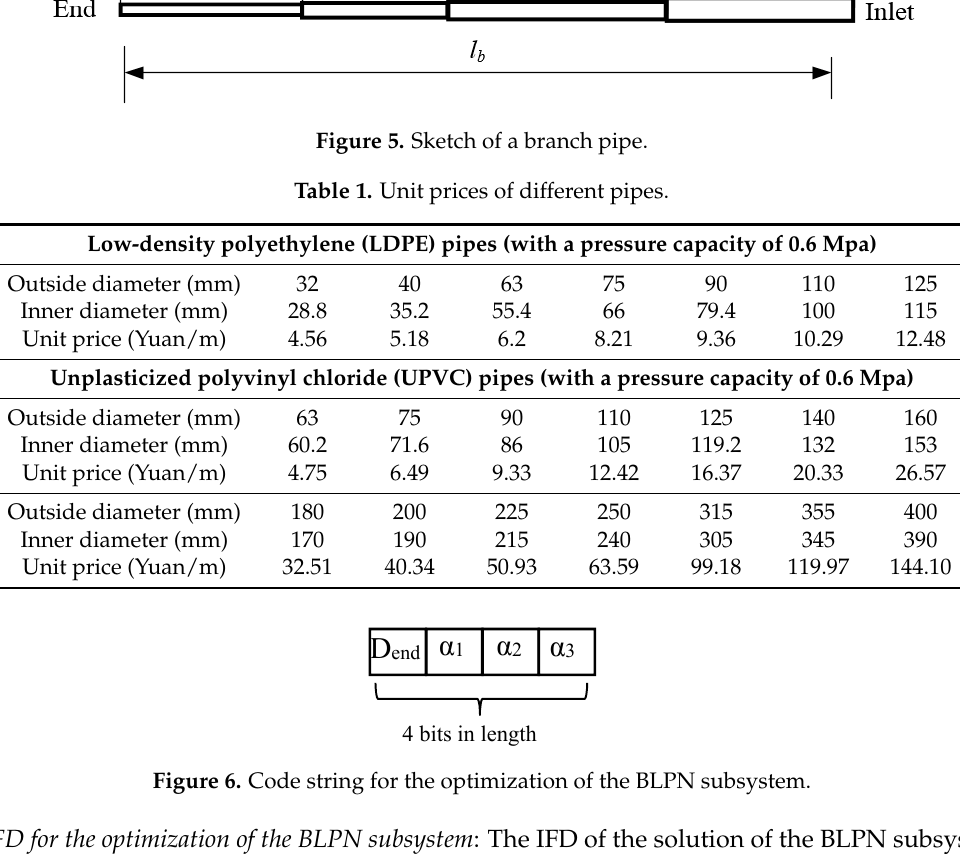
Figure 7. Code string (chromosome) for the optimization of the MSMPN subsystem.